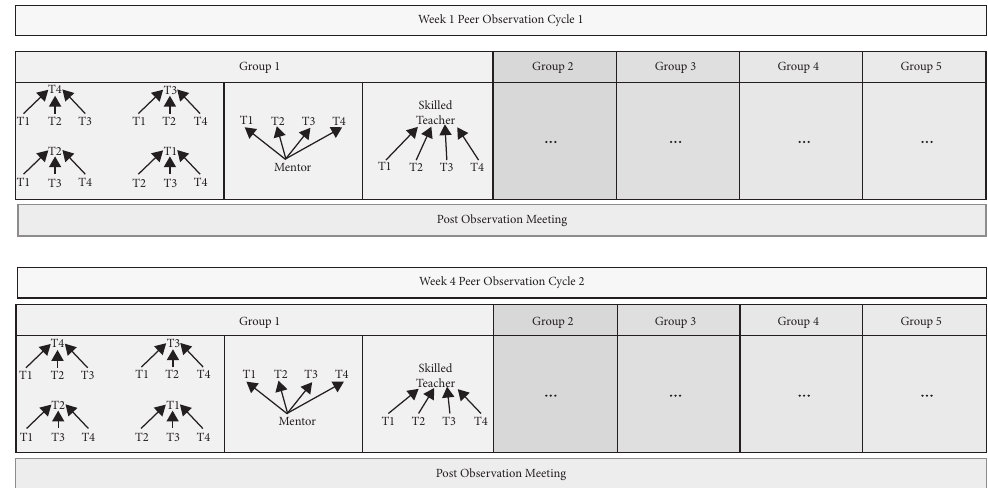
Figure 2: Sources of data collection. Peers observed each other’s sessions and provided feedback. Mentor and skilled teachers who also observed the peers’ sessions provided feedback that was also added to the data being